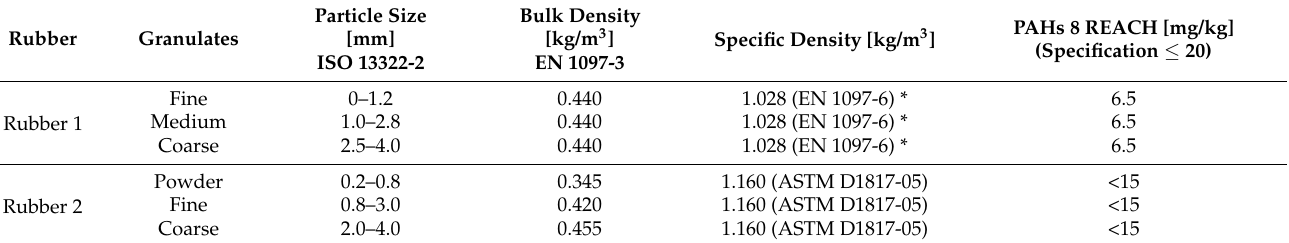
Table A1. Crumb rubber typical values.